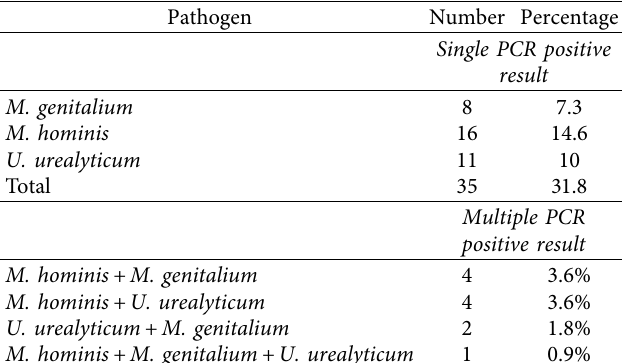
Table 1: PCR results from 110 specimens (semen, urine, and vaginal